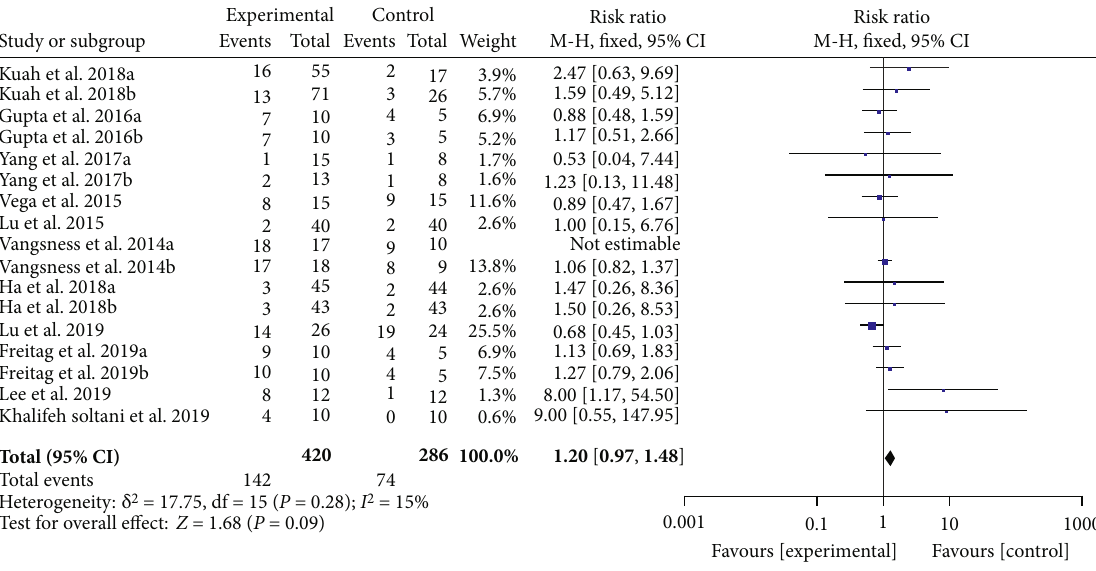
Figure 13: Adverse